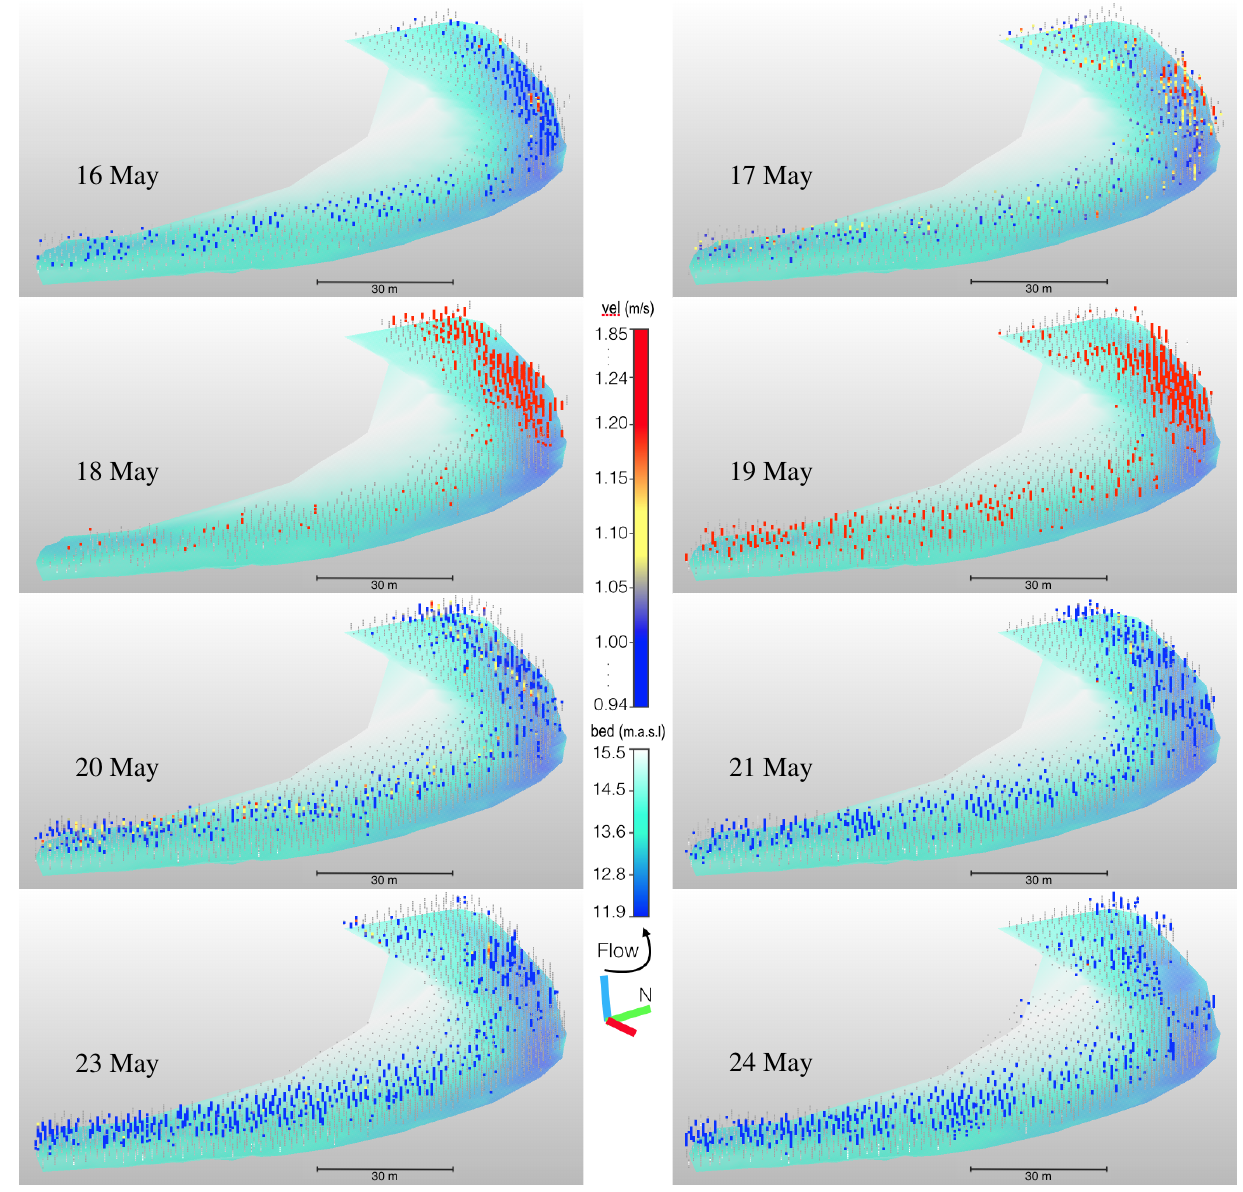
Figure 10. Visualizing the high velocity core (HVC) as a 3D point cloud of flow velocities viewed at an angle, looking downstream. The view angle is indicated by the rotational